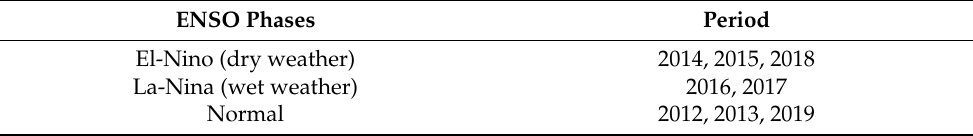
Table 1. ENSO year classification used in this